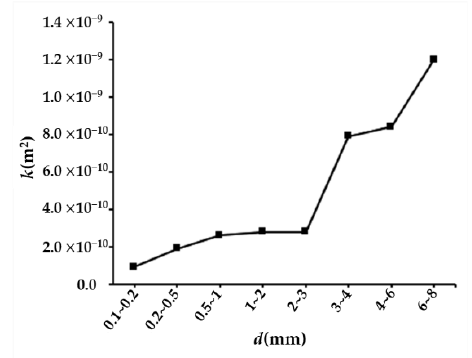
Figure 7. Permeability of sand samples.